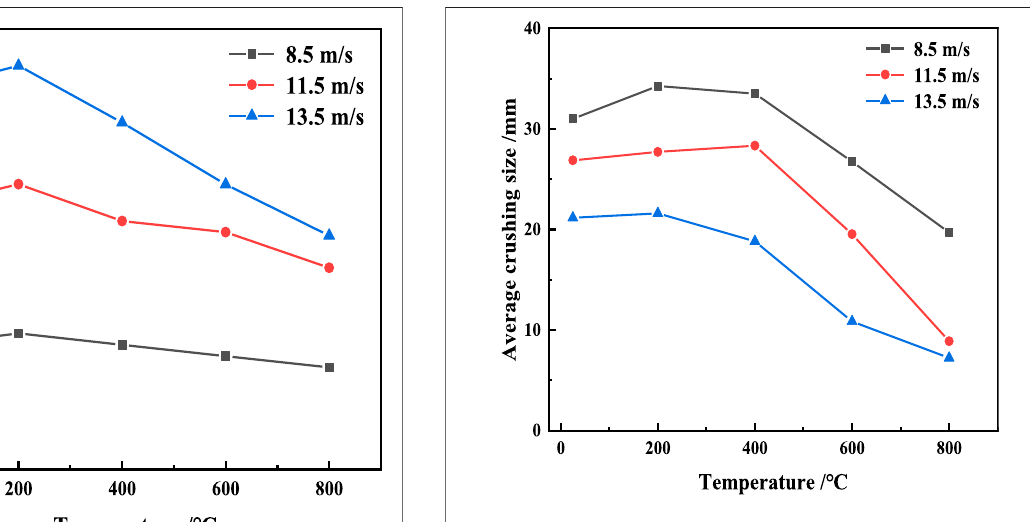
FIGURE 8 | Average fragment size distribution of